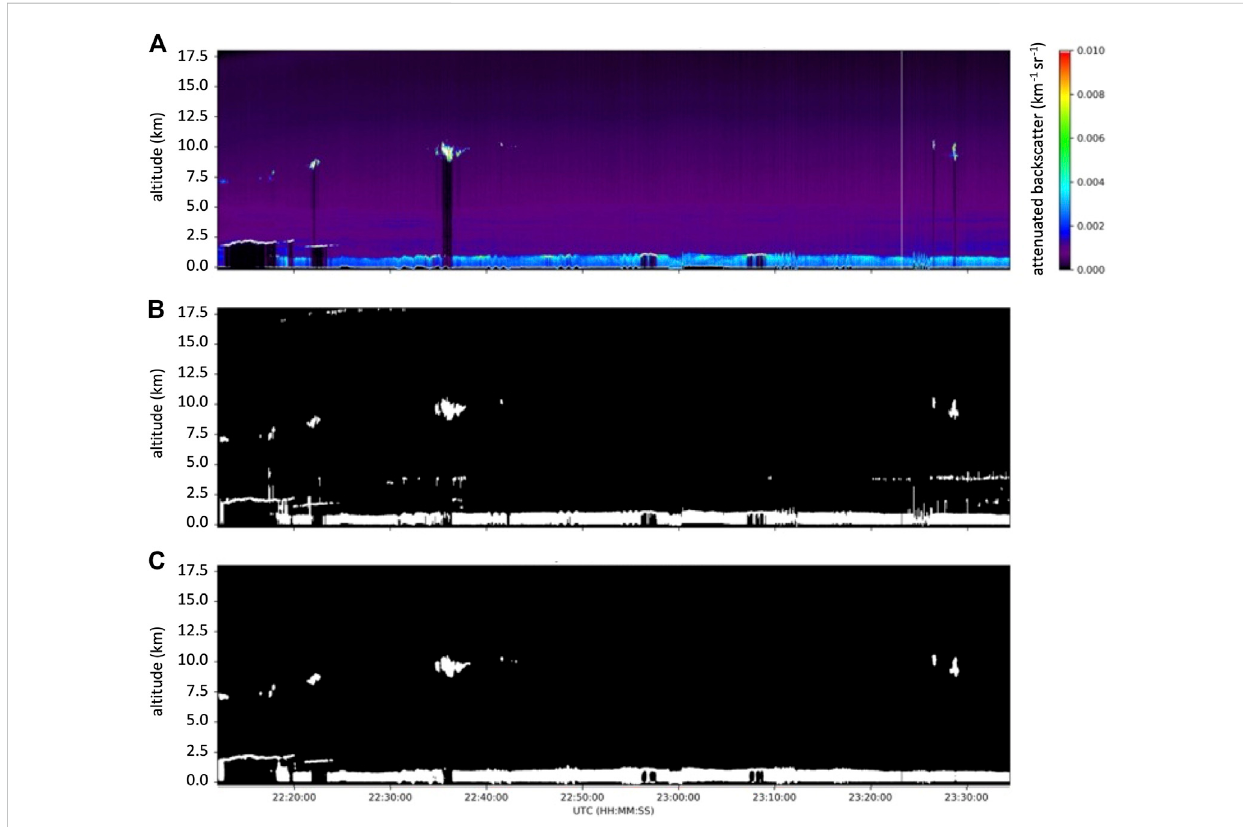
fi nding results from standard CPL data processing (i.e., using traditional processing methods and at 5 s/1 km